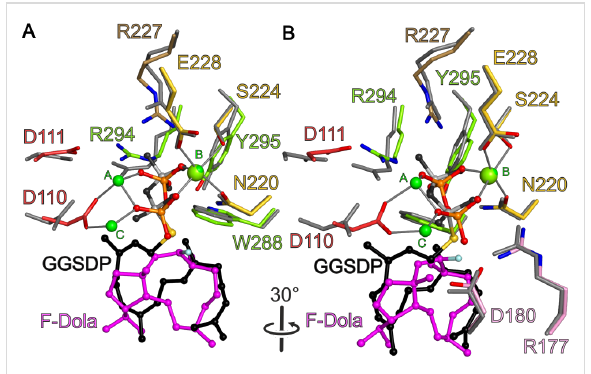
Figure 4: View into the active site of CotB2 wt ·Mg 2+ 3 ·F-Dola [37] super- imposed with CotB2 wt ·Mg 2+ B ·GGSDP [36]. (A) The bound F-Dola reac- tion intermediate is shown in magenta with the fluorine atom colored in light blue, and Mg 2+ ions are shown in green. Residues of the DDXD motif are shown in red and residues of the NSE motif in yellow. The conserved residues of the WXXXXXRY motif are drawn in light green and the R227 that interacts with diphosphate moiety in light brown. The cleaved diphosphate is shown in orange. Gray lines represent the coordination sphere of the Mg 2+ ions. Identical amino acid residues lo- cated in the structure of CotB2 wt ·Mg 2+ B ·GGSDP are shown in gray. The GGSDP molecule is shown in black with the sulfur atom colored in yellow. The position of Mg 2+ B is identical in both structures. For clarity water molecules have been omitted. (B) View in panel A rotated by 30°. In addition to the motifs shown in panel A, the pyrophosphate sensor motif is depicted in pink.